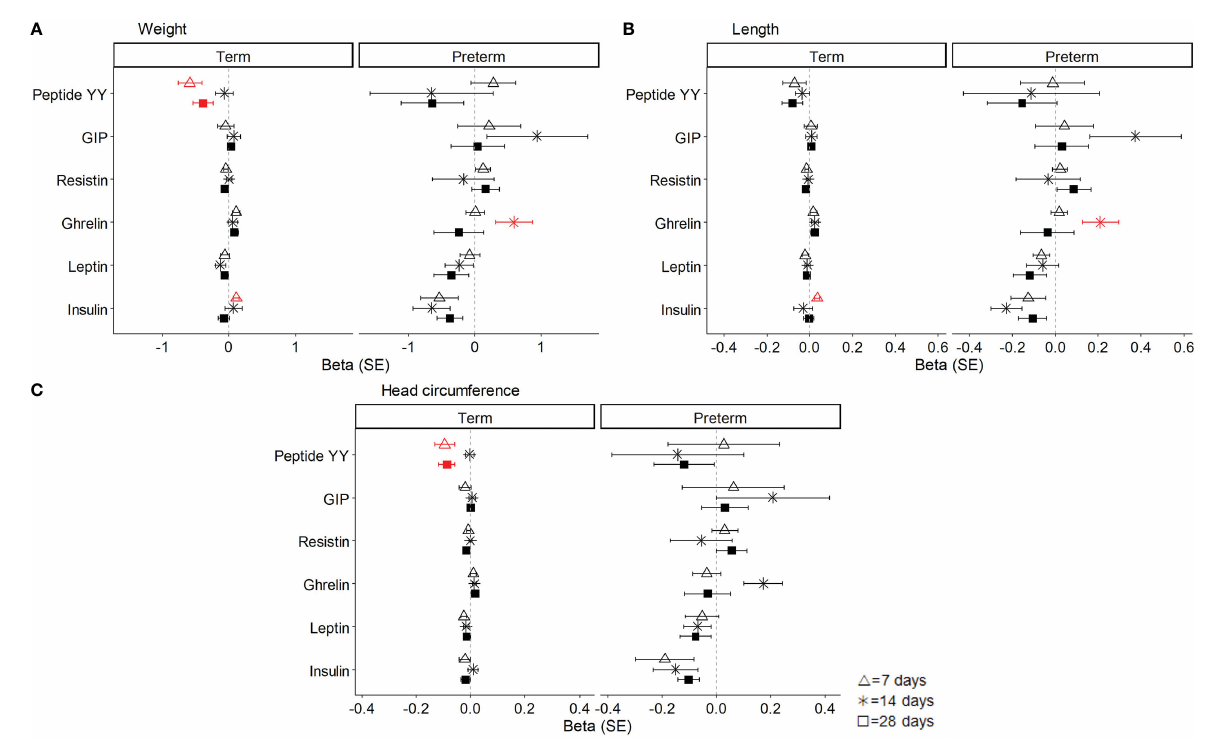
FIGURE 4 Linear regression models showing the association between breast milk (BM) hormones and neonatal weight (A) , length (B) , and head circumference (C) . The neonatal growth variables were normalized by logarithmic transformation, and the coef fi cients (beta) for each day of lactation were separately analyzed. Data show beta and standard error (SE). The red lines mean signi fi cant association (P < 0.05), and non-signi fi cant associations are represented in black. All models were adjusted by sex and women fat mass percentage. GIP, gastrointestinal